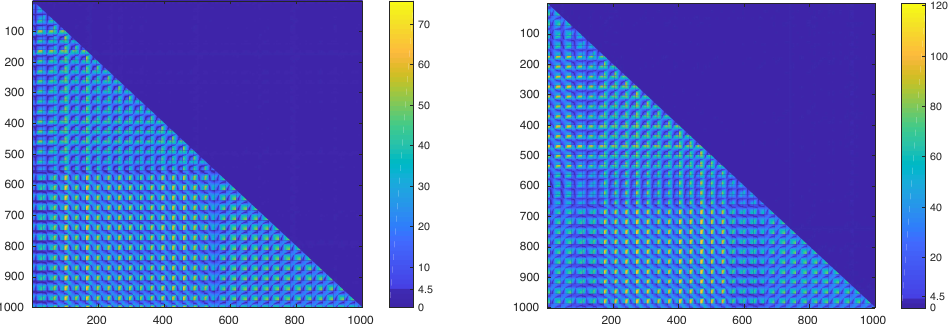
Figure 11: Bivariate t-test on second-order secure M&M AES imlementation, V1 (left) and V2 (right). Below diagonal: PRNG off (20K traces); Above diagonal: PRNG on (50M